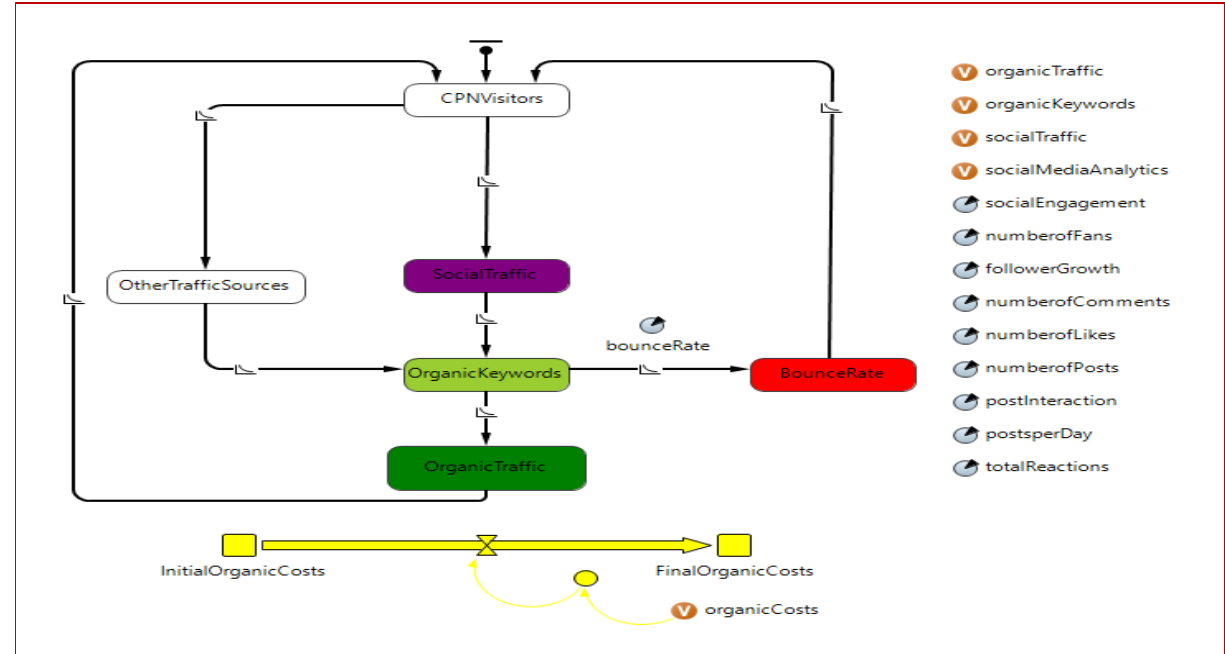
Figure 4. Agent-based model development.